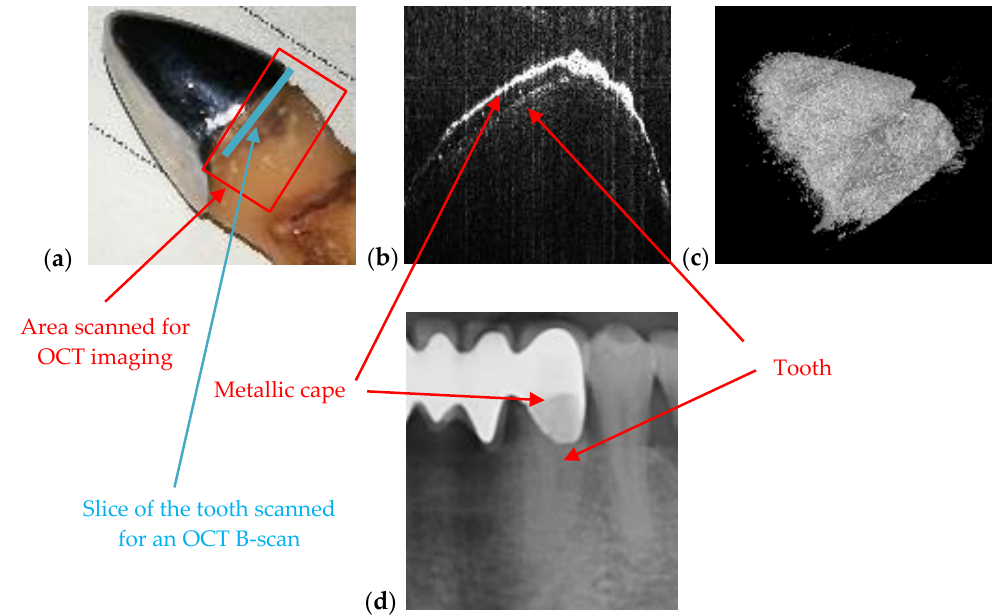
Figure 13. OCT used to check the adaptation of metallic cape on the tooth: ( a ) photo of the tooth with cape, ( b ) OCT B-scan showing both the tooth and the metallic cape, ( c ) 3D reconstruction, and ( d ) section cropped from a panoramic radiography. Patient S.S., female, age 57 years, diagnosed with multiple abscessed teeth and periodontitis.